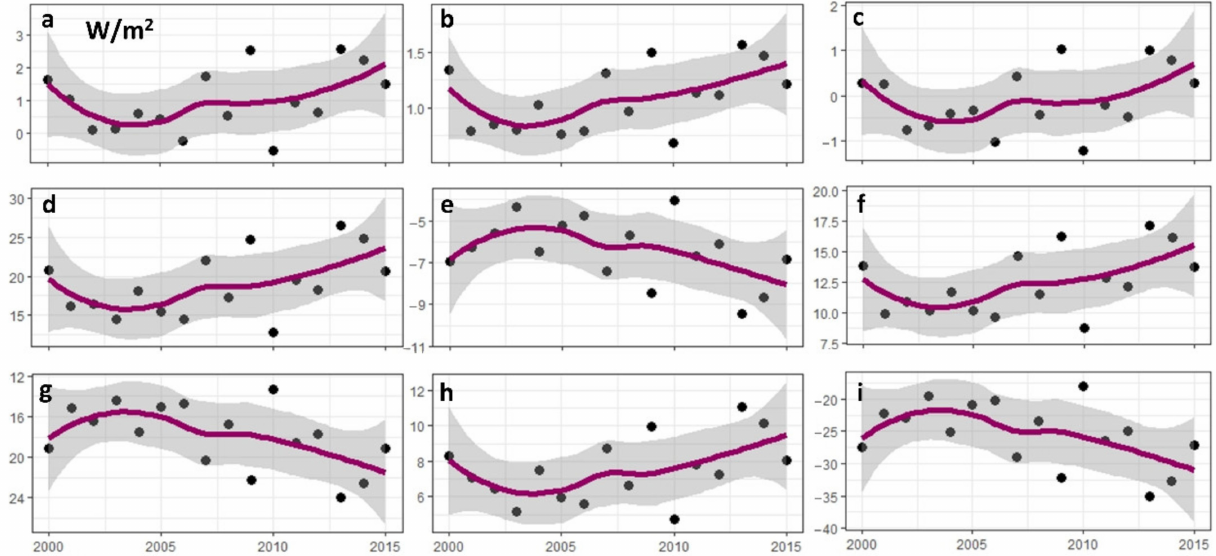
Figure A3. Trends of dust aerosol radiative forcing in spring. ( a ) Shortwave radiative forcing at the top of the atmosphere; ( b ) longwave radiative forcing at the top of the atmosphere; ( c ) net radiative forcing at the top of the atmosphere; ( d ) short- wave radiative forcing in the atmosphere; ( e ) longwave radiative forcing in the atmosphere; ( f ) atmospheric net radiative forcing; ( g ) surface shortwave radiative forcing; ( h ) surface longwave radiative forcing; ( i ) surface net radiative forcing.